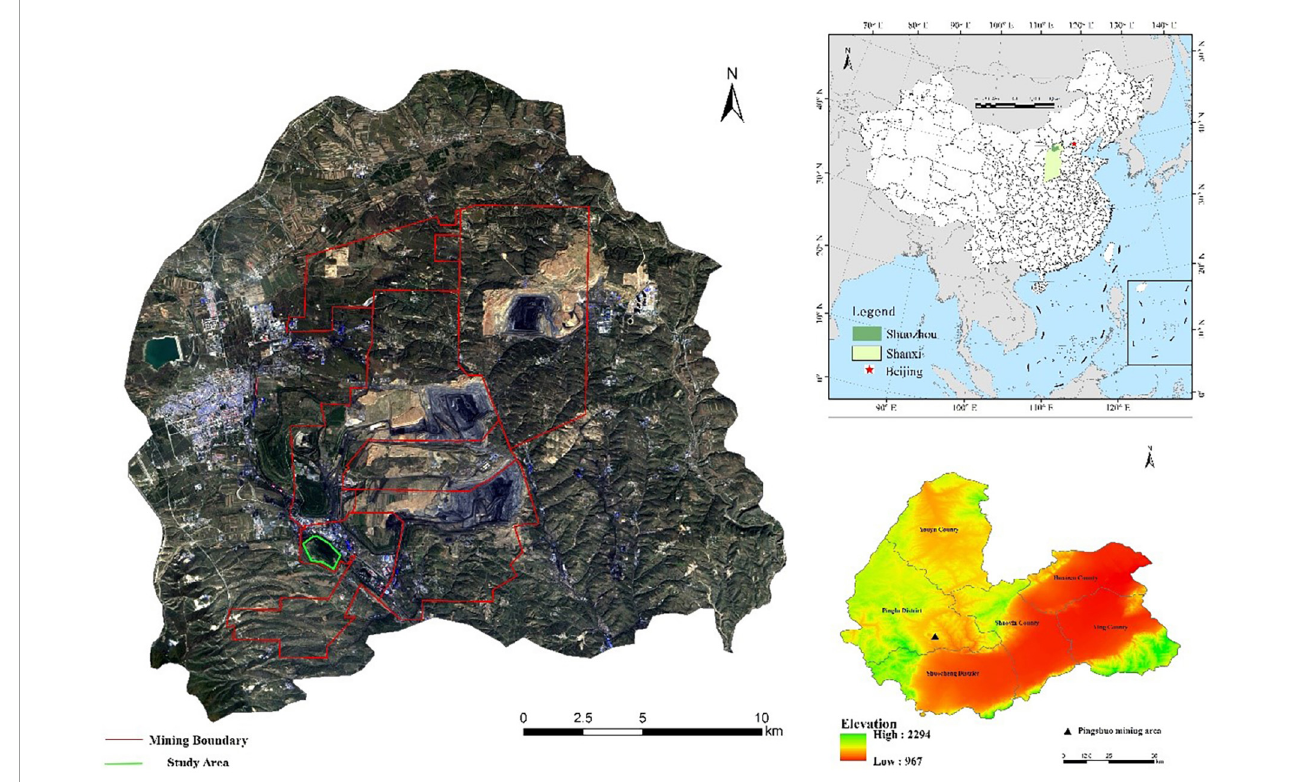
FIGURE1 Location map of the study area.